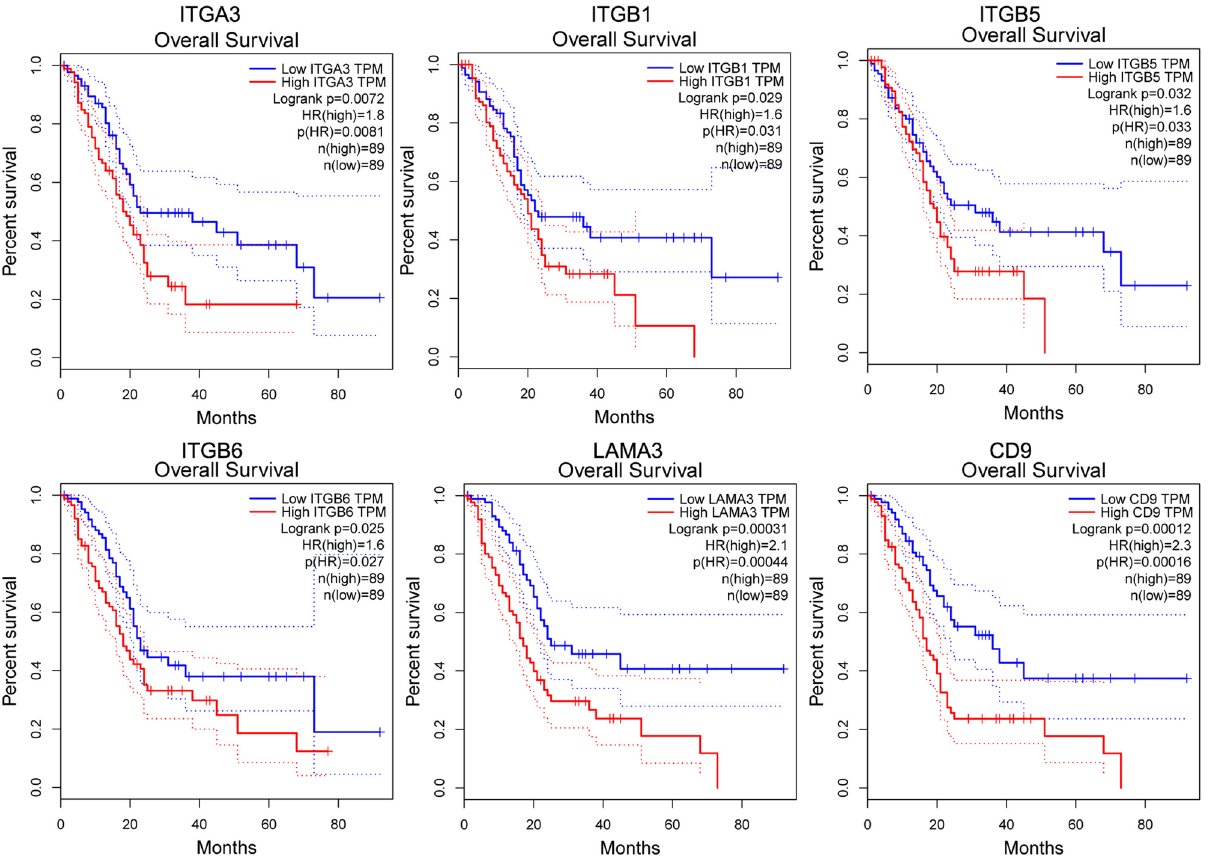
Figure 5: Gene expression pro fi ling interactive analysis ( GEPIA ) of ITGA3 and related genes. GEPIA performs overall survival analysis using the log - rank test. Dotted line indicates 95% con fi dence